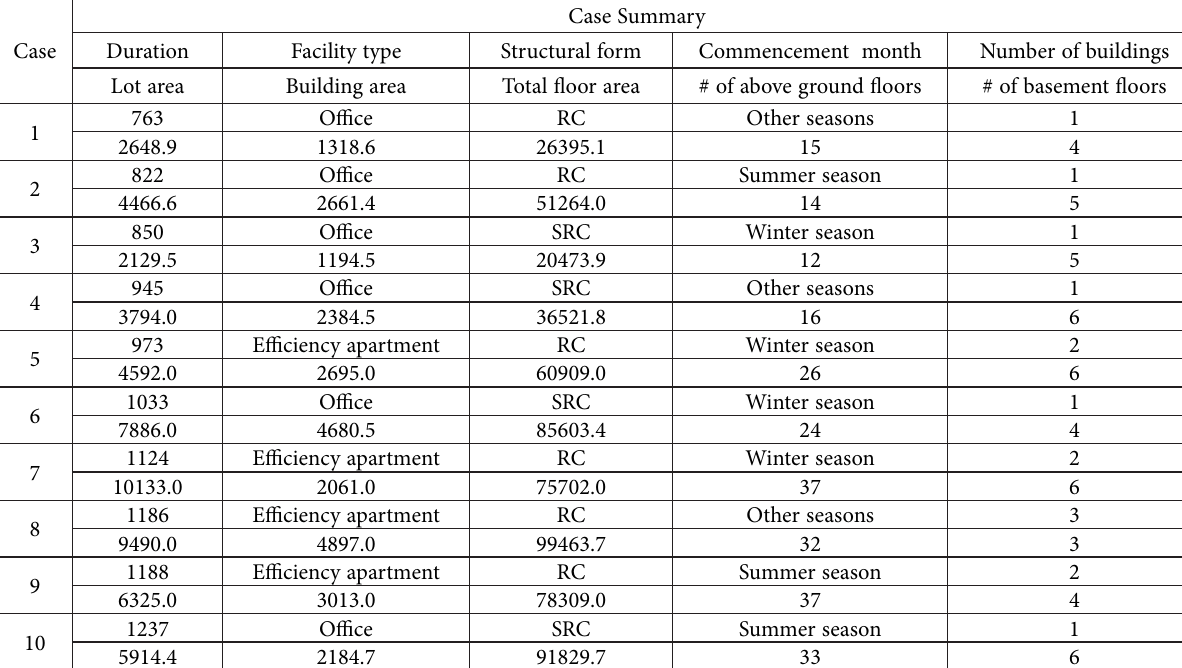
Table 13. Outline of the case